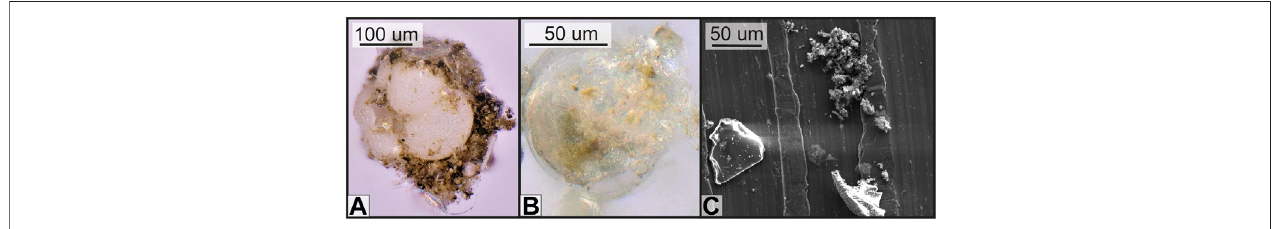
FIGURE 6 | Digital microscope and scanning electron microscopy (SEM) imagery of (A) an OC-rich aggregate, (B) organic carbon coating a mineral grain, and (C) SEM imagery of simultaneously occurring pure mineral grains and OM-rich particles from stations offshore 23 ° S. The organic matter visually coats the grains and associates with pores and other uneven surface structures.